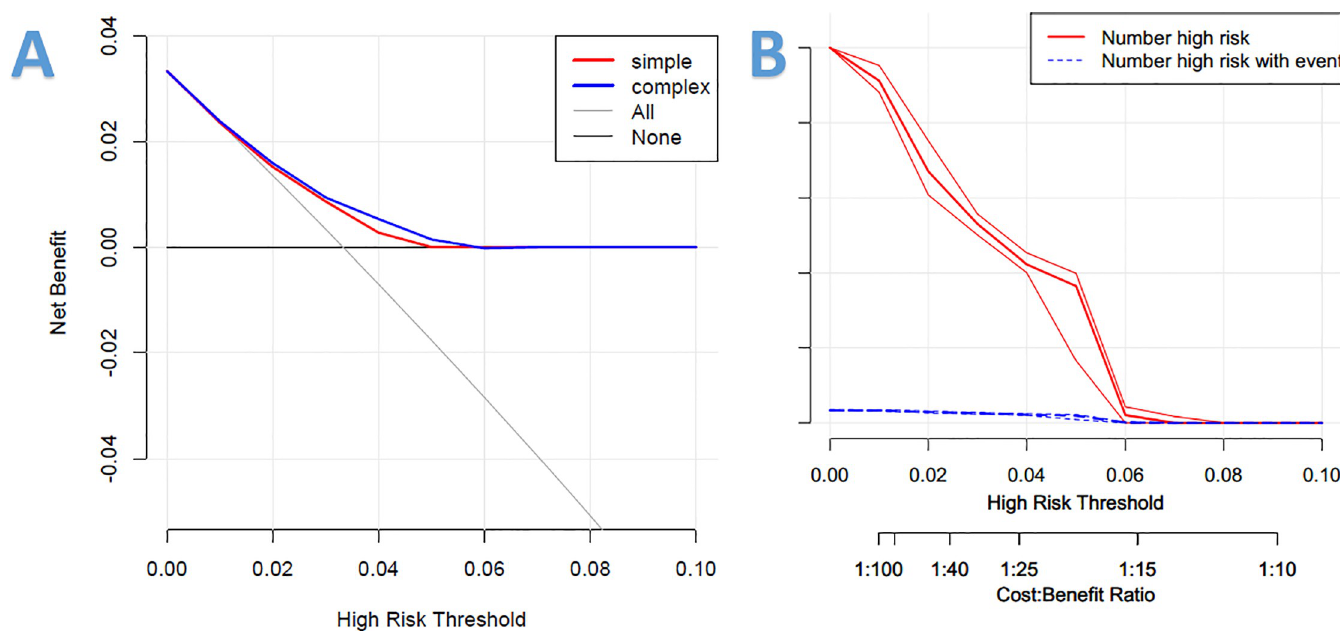
Fig 4. Decision analysis curve and clinical impact curve of risk prediction model. (A)Decision analysis curve(Simple = Radiation treatment; Complex = Risk prediction model); (B)Clinical impact curve.